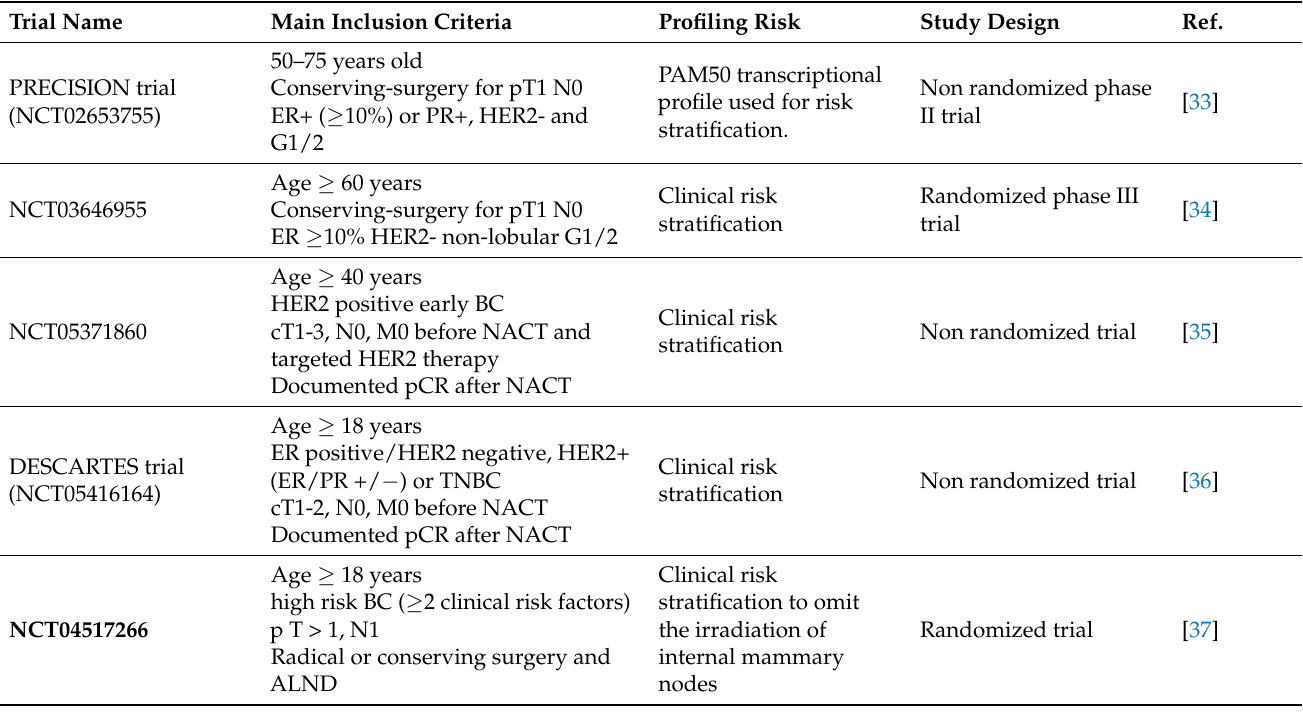
Table 1. Ongoing trial evaluating the impact of omission/reduction of RT for BC